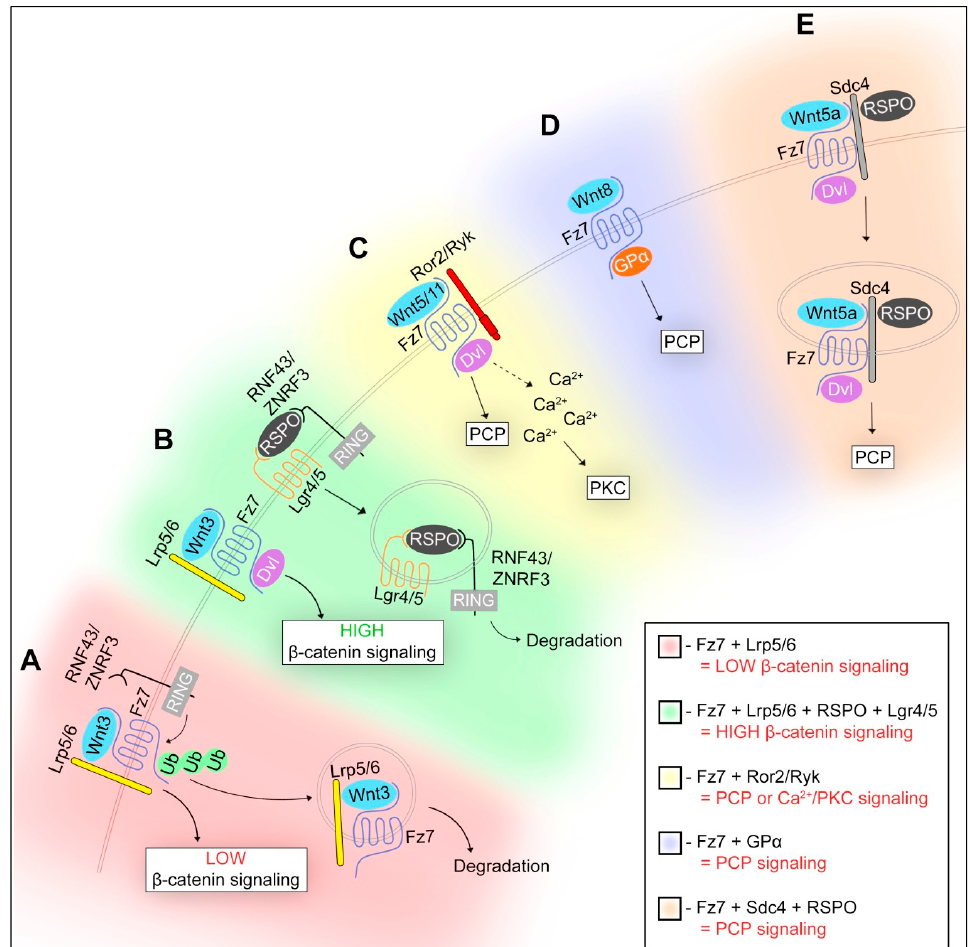
Figure 1. Fzd7 receptor complexes and signalling output. ( A ) Fzd7 (Fz7) can associate with Lrp5/6 to